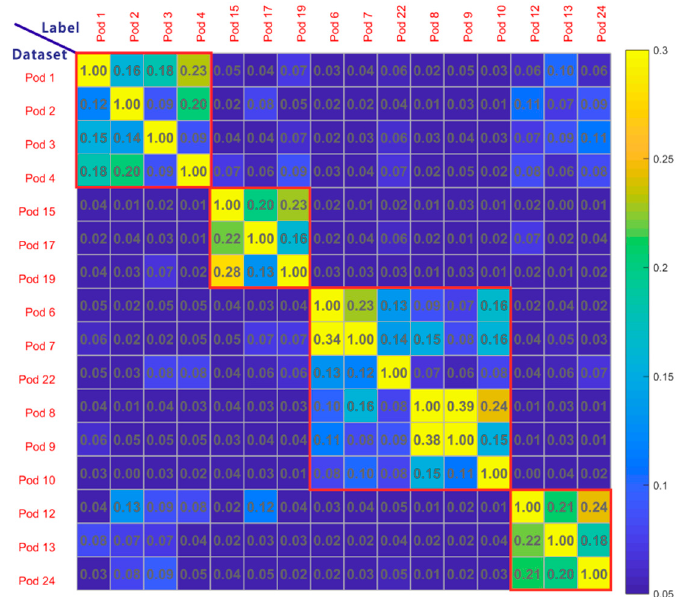
Figure 3. The similarity matrix based on the Softmax ‘likelihood’ vectors (color online).